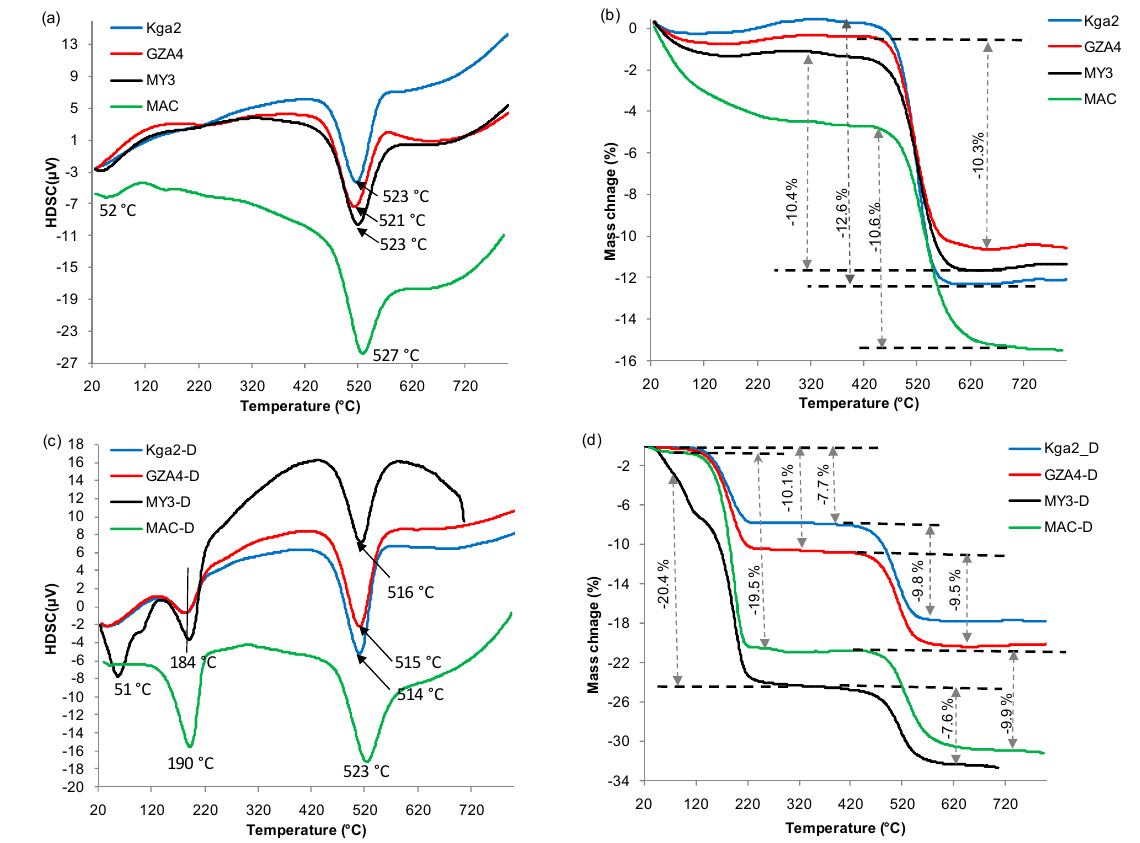
Figure 4. DSC-TGA analysis of ( a , b ) the raw and ( c , d ) the DMSO–intercalated kaolinite.